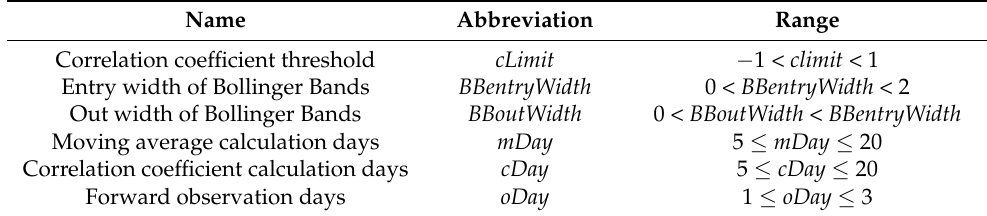
Table 2. Predefined ranges of six